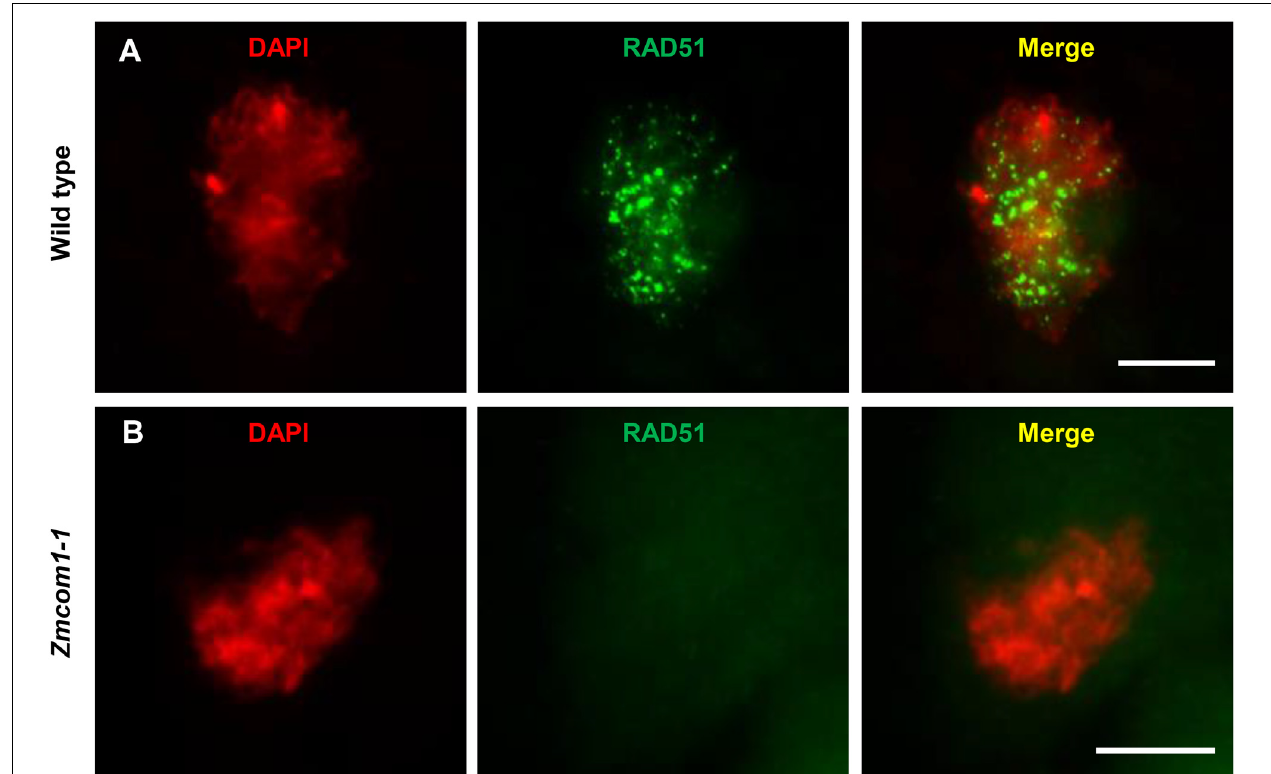
FIGURE 6 | Immunolocalization of RAD51 antibodies in the wild type and Zmcom1-1 meioctyes at zygotene. (A) Wild type, (B) Zmcom1-1 mutant. DAPI staining is used to indicate the chromosomes. Scale bars = 10 µ